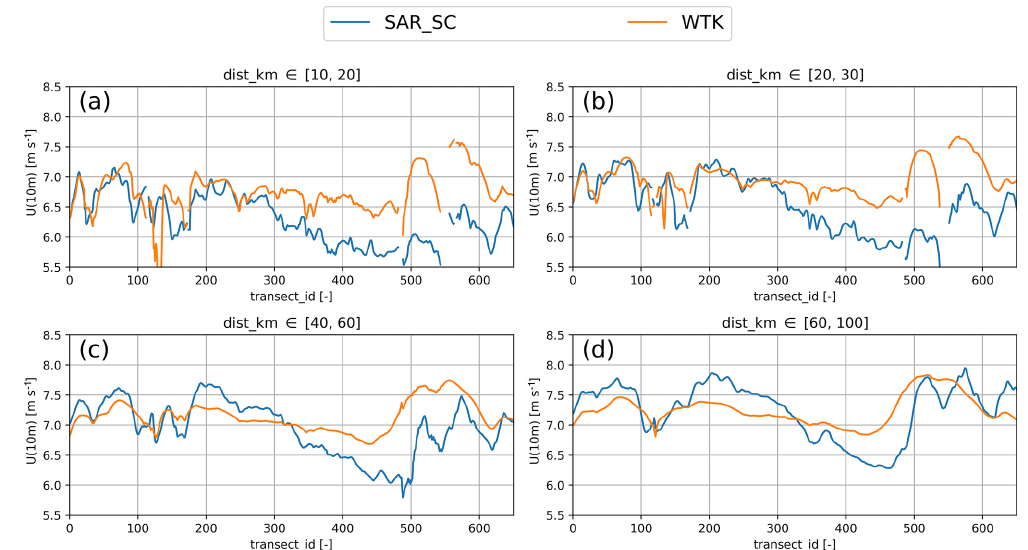
Figure 11. Along-shore variation in the mean wind speeds for distance to shore intervals of (a) [10, 20], (b) [20, 30], (c) [40, 60], and (d) [60, 100]km.